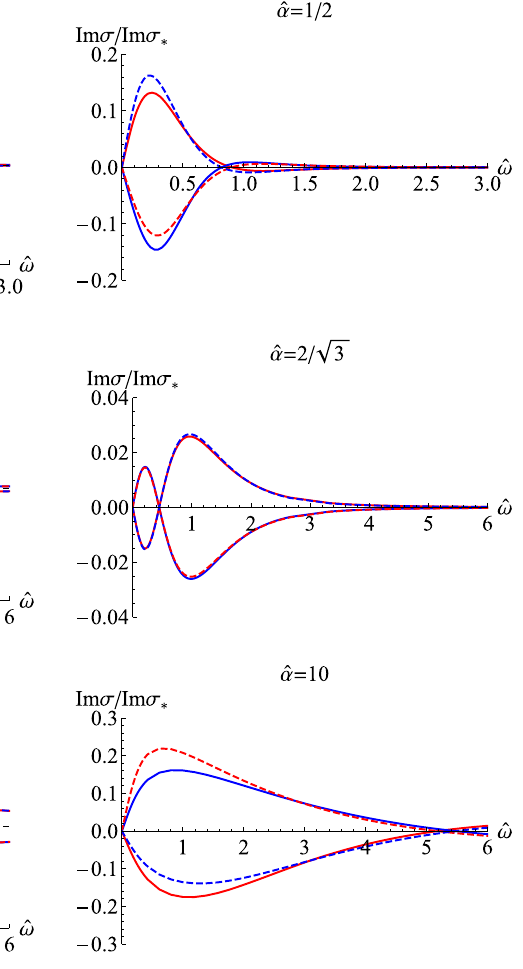
for γ = − 1 / 12). While the dashed curves display the conductivity of theEMdual theory(7) forthesamevalue of γ and ˆ α .(For interpretation of the references to color in this figure, the reader is referred to the web version of this